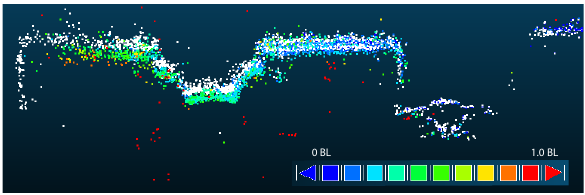
Figure 4: Comparison of the two resulting point clouds using our approach (white) and algebraically estimated initial values (coloured, depending on the distance to the other point